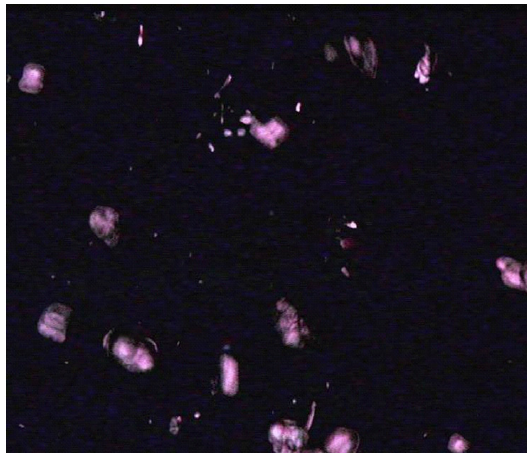
Fig.9 OPM of PBSeBT at